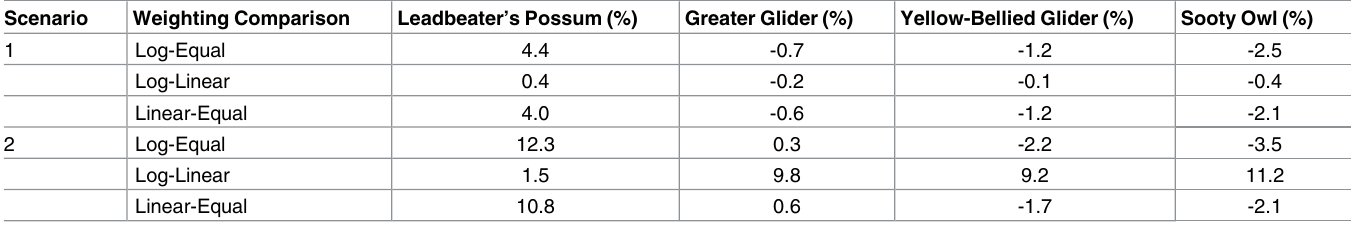
Table 5. Pairwise difference (%) of cumulative values of distributions captured under the reservescenarios using the different species weighting schemes for each of the target species. Scenario Weighting Comparison Log-Linear Linear-Equal